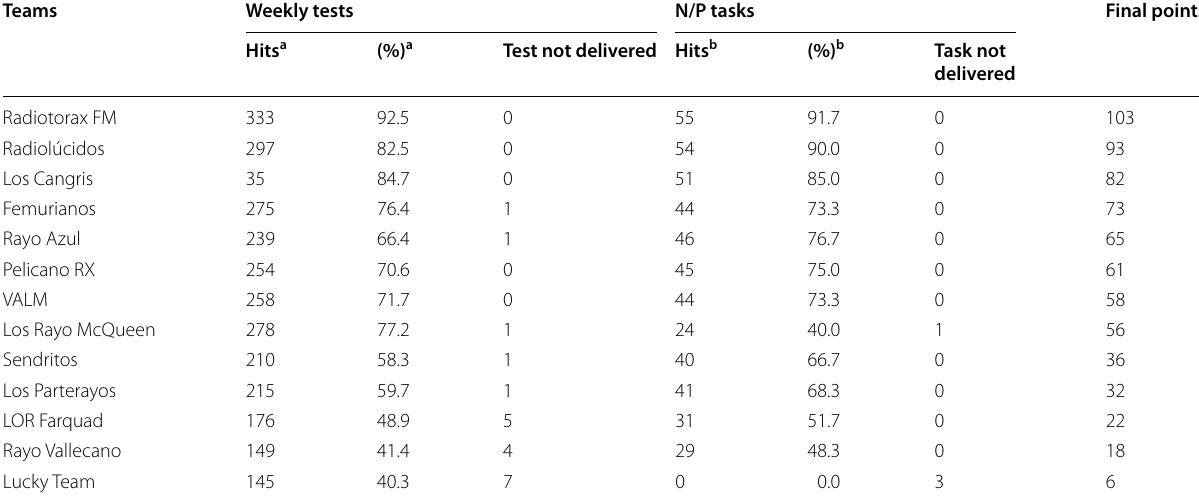
Table 1 Results of the 13 participating teams, classified according to the final classification